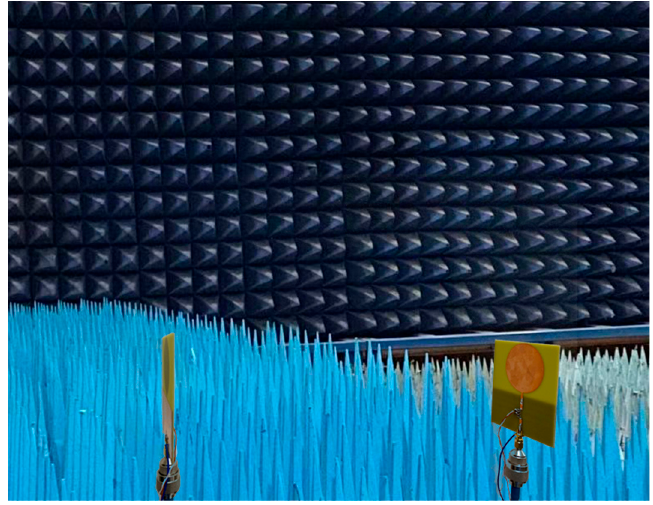
Figure 11. Physical scene of the measurement for time domain (transmitted (Tx), received (Rx), R = 1000 mm).